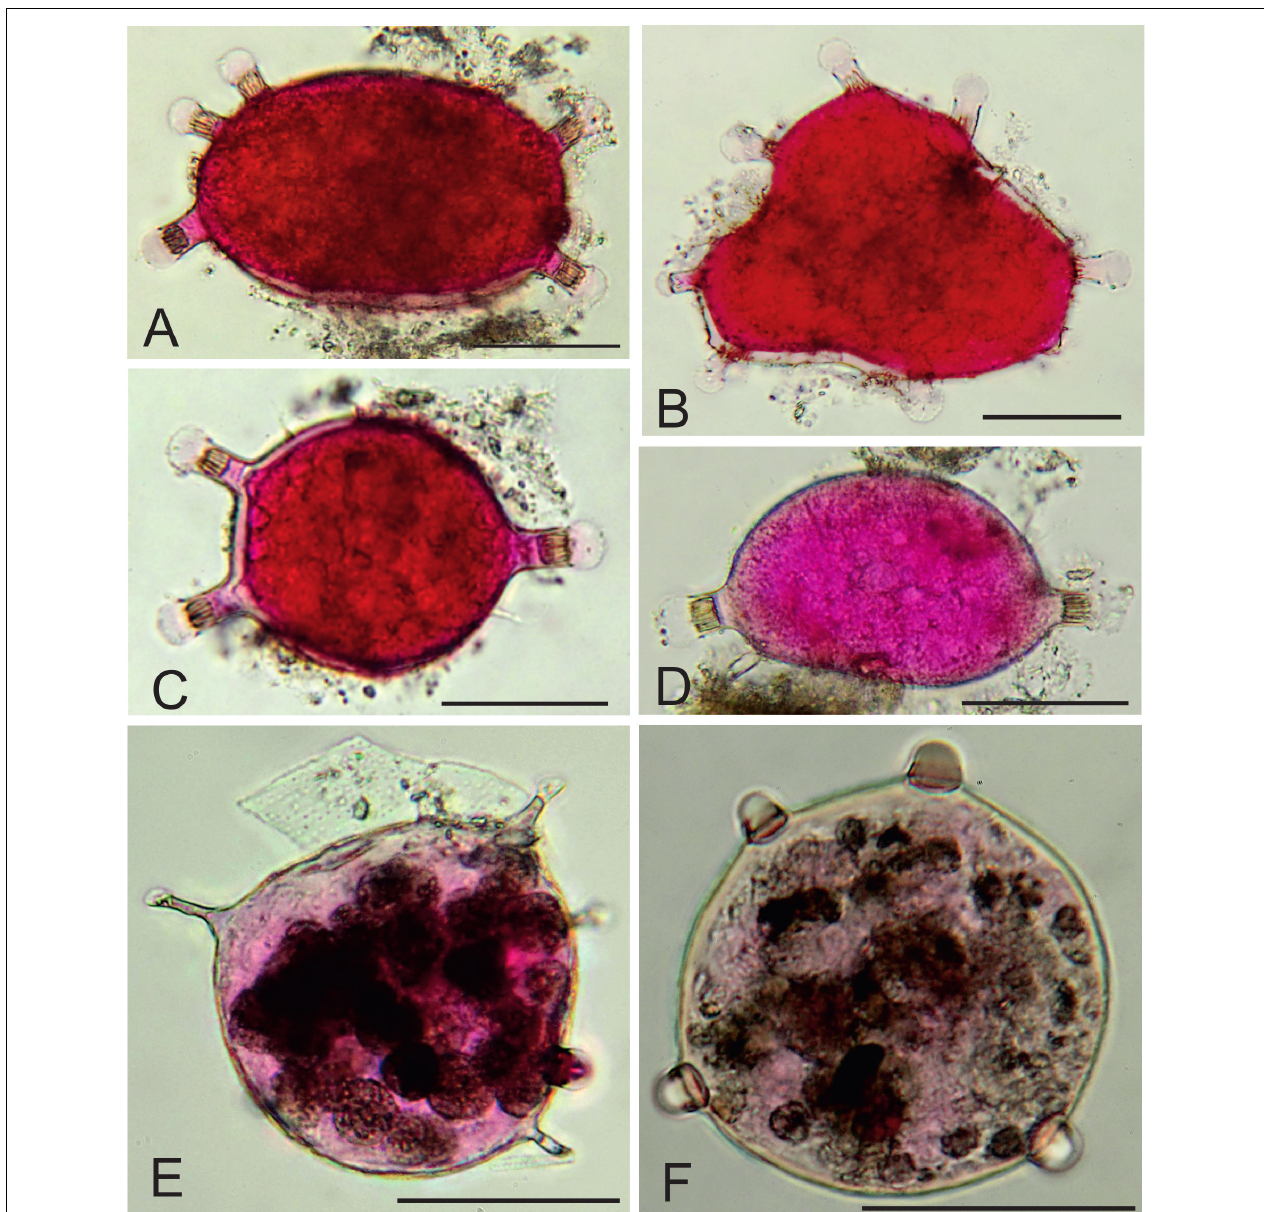
FIGURE 5 | Unidentified organic-walled structures (?metazoan eggs) from 63–125 µ m fractions. (A–C) Type A with short striated tubes ending in thin-walled bulbs; MC11, 0–0.5 cm layer. (D,E) Type B with relatively long slender tubes, sometimes ending in a small thin-walled bulb; MC11, 0–0.5 cm. (F) Type C with rounded bumps; MC13, 0.5–1.0 cm layer. Scale bars = 50 µ